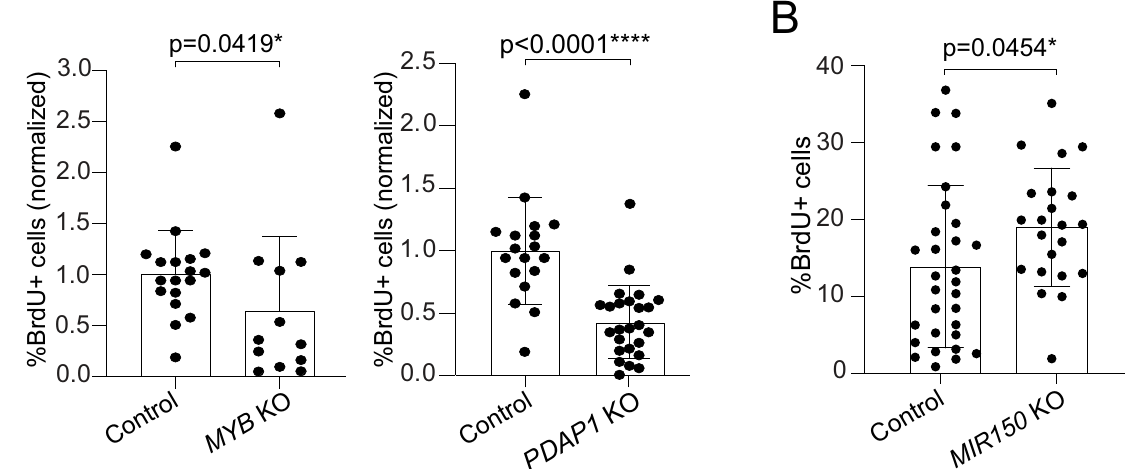
Fig 5. miR-150 restrains T-cell proliferation through MYB and PDAP1. (A) Primary memory T cells were transfected with Cas-9 RNPs to delete either MYB (left) or PDAP1 (right), followed by single-cell cloning. Individual clones were selected based on the presence of a large genomic deletion in the gene of interest, and proliferation was measured by BrdU incorporation assay. For the MYB gene, N = 18 control clones and N = 12 MYB -edited clones, from 2 independent donors. For the PDAP1 gene, N = 18 control clones and N = 25 PDAP1 -edited clones, from 2 independent donors. Mean ± SD. Mann–Whitney test. (B) Memory T cells were transfected with Cas-9 RNP complexes containing 2 different sgRNAs targeting the MIR150 gene. Individual clones were selected based on the presence of a genomic deletion overlapping the MIR150 sequence, and proliferation was measured by BrdU incorporation assay. N = 31 control clones and N = 22 MIR150 -edited clones, from 2 independent donors. Mean ± SD. Welch t test, 2 tailed. Underlying data can be found in S1 Data. sgRNA, single-guide RNA; KO, knockout; PDAP1, PDGFA-associated protein 1; RNP,